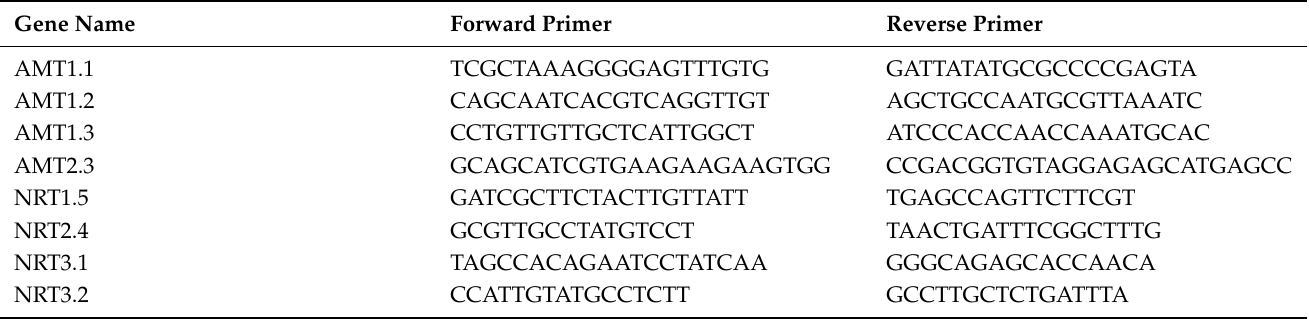
Table 1. Primers used for qRT-PCR analysis of selected